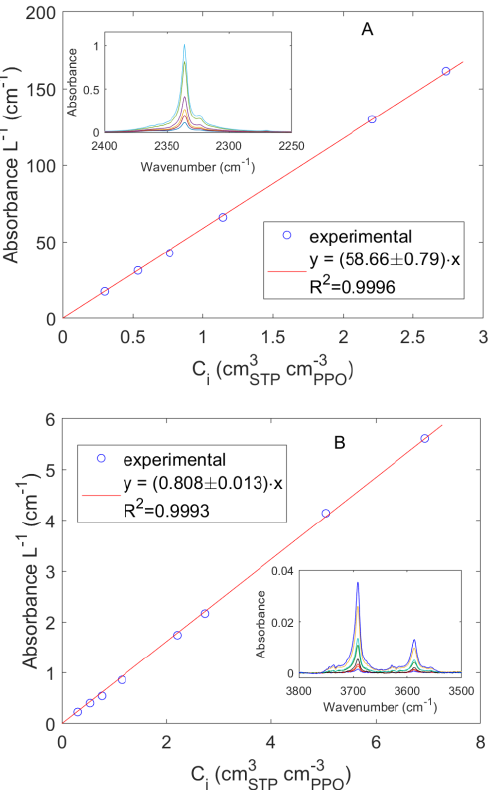
Figure 6. Correlation between the absorbance measured at 2 cm −1 frequency resolution and the concentration of carbon dioxide in PPO. ( A ): IR peak centered at 2336 cm −1 ; ( B ): IR peak centered at 3692 cm −1 .